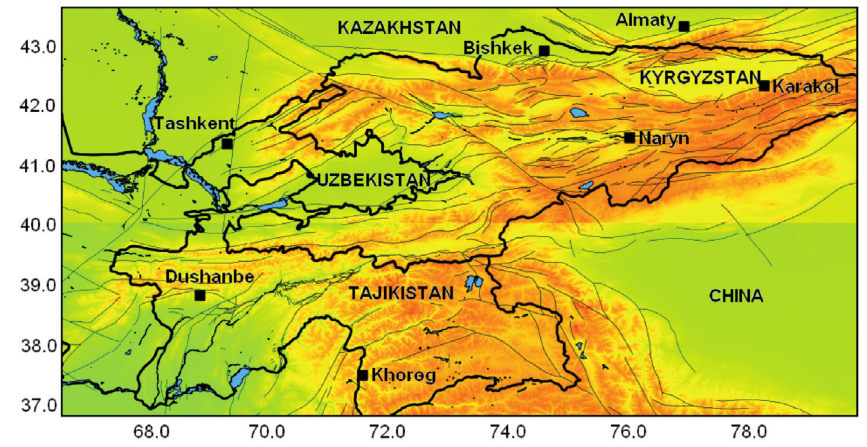
Figure 1. Map of Central Asia indicating all cities in which site effects studies have been carried out. The main active faults (thin black lines; Trifonov et al. [2002]) are